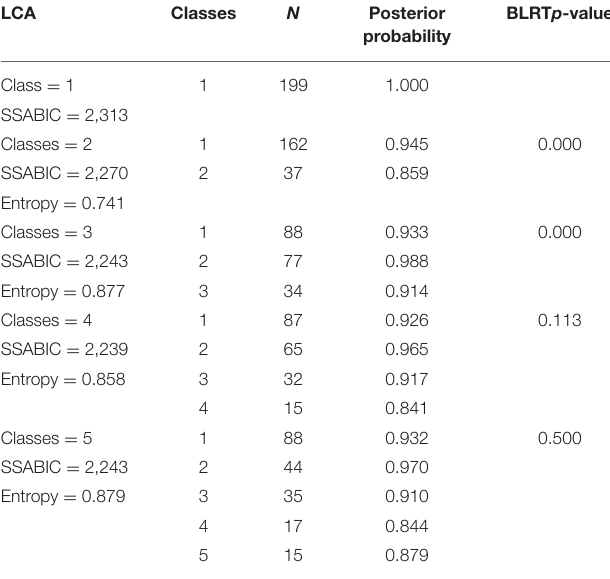
TABLE 2 | Clinical diagnosis and care characteristics of the monitoring sample ( n = 199).